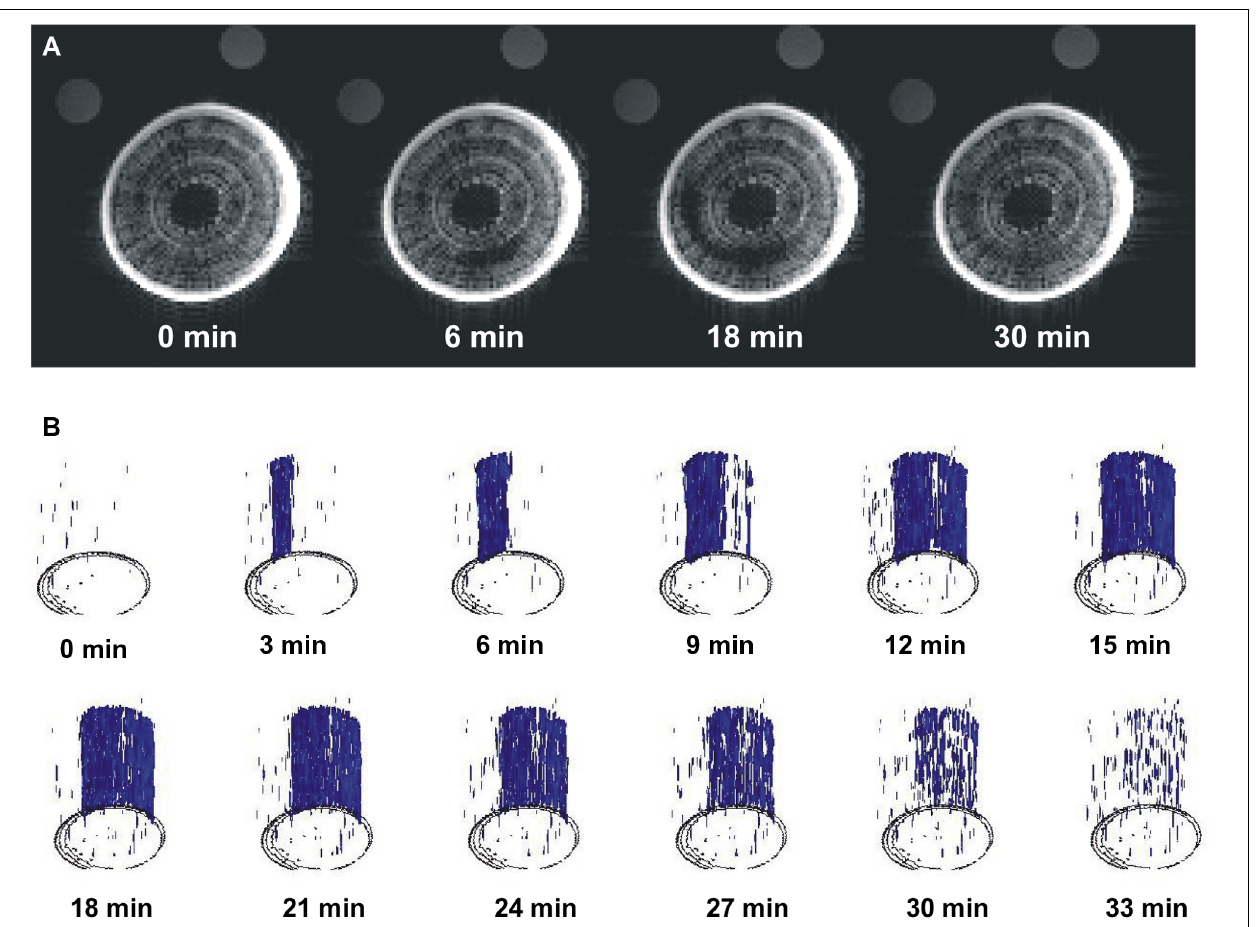
dimensional analyses of embolism formation, its spatial spread, and recovery. The blue color denotes volumes with 90% loss of pixel brightness. Please note that to improve embolus visibility, images were reoriented in respect to the MRI images. Please consult the Supplementary Material online (Video S1 and